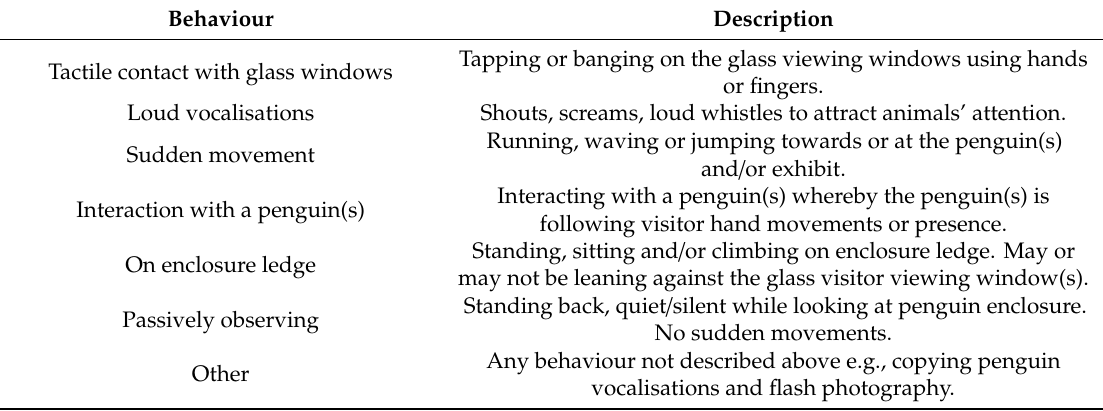
Table 2. Ethogram of visitor behaviours adapted from Chiew et al.